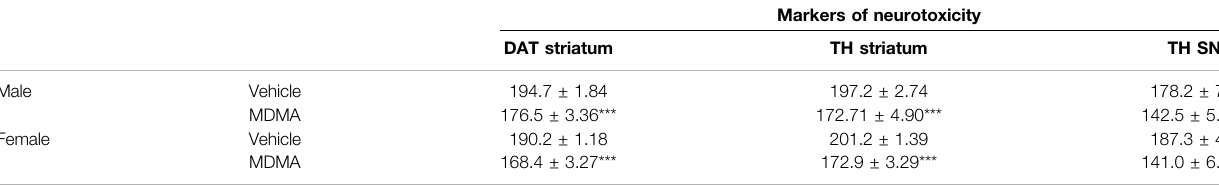
TABLE 3 | Effects of treatment with MDMA on the immunoreactivity for the dopamine transporter (DAT) in the striatum and on the immunoreactivity for tyrosine hydroxylase (TH)inthestriatumandsubstantianigraparscompacta(SNc).AdultmaleandfemalemiceweretreatedwitheitherMDMA(4 × 20 mg/kg,i.p.,2 hapart)orvehicle(saline solution, i.p.). N (cid:2) 5-6 mice per group. Values are reported as mean ± S.E.M. For DAT and TH in the striatum, data are expressed as mean density values. For TH in SNc the number of TH-positive neurons is reported. ***p < 0.001 compared with the respective groups of vehicle-treated mice by Newman-Keuls post-hoc test.